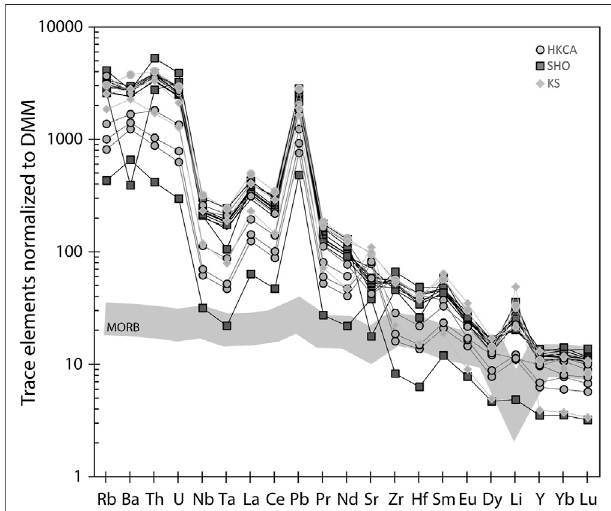
FIGURE 6 | Spidergrams of ST2 melt inclusions. Symbols are the same as in Figure 4 and represent the different groups of melt inclusions. The different groups cannot be differentiated based on their trace element compositions. Trace elements havebeen normalizedtoDMM (Ryan and Langmuir, 1987; Workman and Hart, 2005). ST2 melt inclusions are enriched in mobile elements compared to MORB (Hofmann,